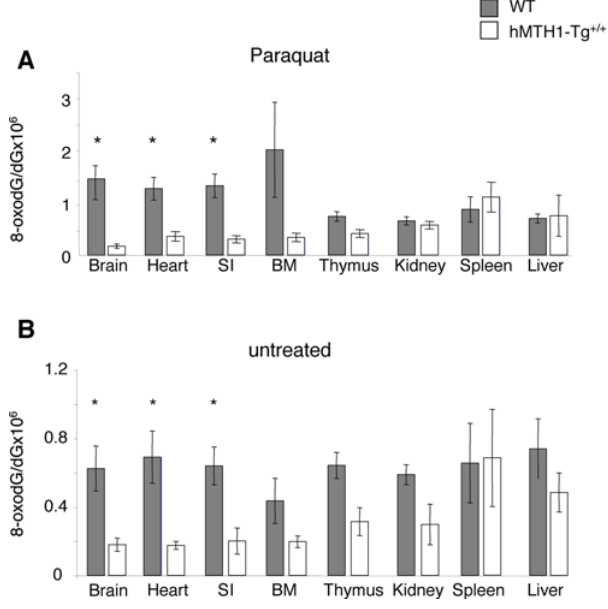
Figure 4. Paraquat-induced DNA 8-oxodG in wild-type and hMTH1-Tg + / + mice. (A) Groups of mice (n=13) were injected 5 times every other day with 10 mg/kg paraquat per injection. DNA from the indicated organs was digested and levels of 8-oxodG were determined by HPLC-EC. Wild-type (filled bars); hMTH1-Tg + / + (open bars). Significant differences (Student’s t -test) between wild-type and hMTH1-Tg + / + organs are shown with an asterisk. The p values were 0.01, 0.03 and 0.04 for brain, heart and small intestine, respectively. SI, small intestine. BM, bone marrow. Values are the mean 6 standard errors. (B) Groups of control mice (n=10) that had received saline injections on the same schedule of Paraquat-treated animals were sacrificed 2 days after the final injection. DNA 8-oxodG was determined in various organs as described above. Wild-type (filled bars) and hMTH1-Tg + / + (open bars). The p values (Student’s t -test) were 0.02, 0.01 and 0.01 for brain, heart and small intestine, respectively. Values are the mean 6 standard errors.